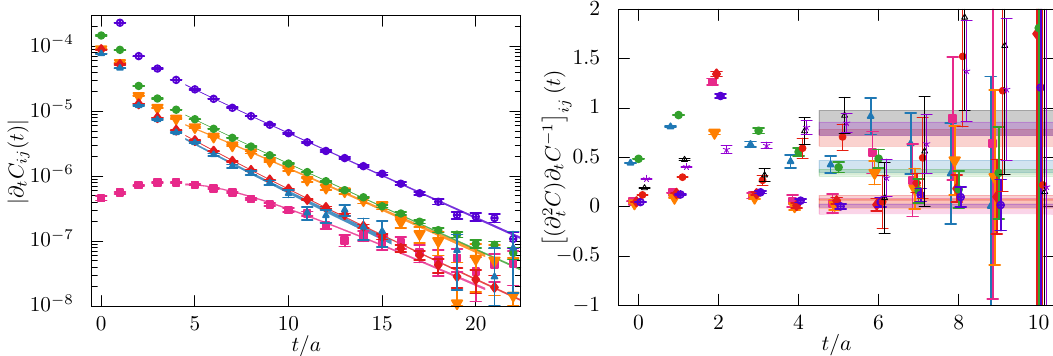
Figure 3. (Left) The moduli of C ij ( t ) determined on ensemble H105 at momentum a 2 ~k 2 = 1 . (Right) The elements of the generalized effective mass matrix, eq. (4.15). The shaded regions in both panels correspond to the results of a simultaneous fit to eqs. (4.9) and (4.15). The widths of the regions indicate the fit